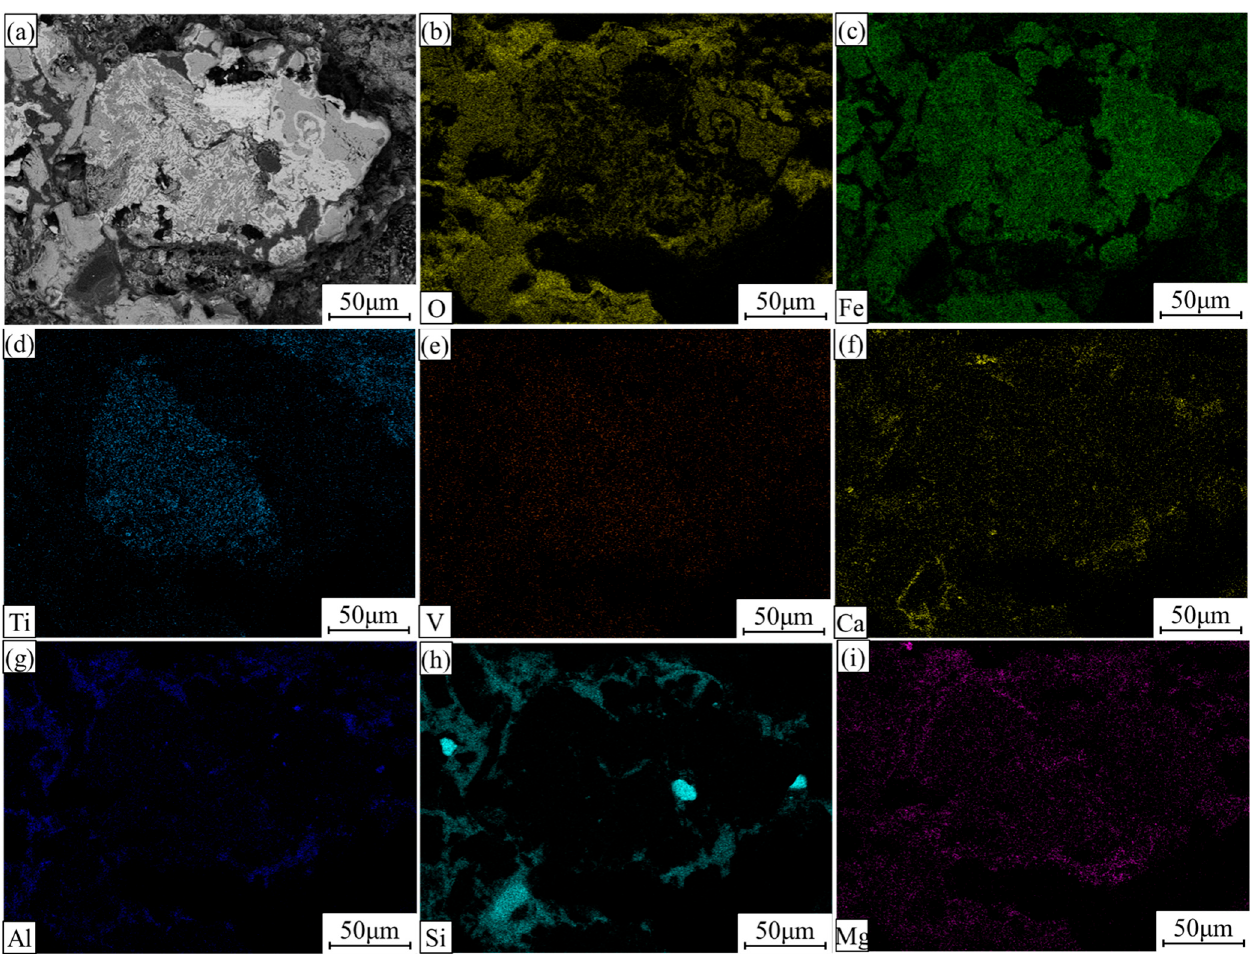
Figure 20. Elemental distributions of the oxidized pellets with 40% sea sand ore reduced at 900°C for 3 h. ( a ) Electronic image; ( b ) O; ( c ) Fe; ( d ) Ti; ( e ) V; ( f ) Ca; ( g ) Al; ( h ) Si; ( i ) Mg.